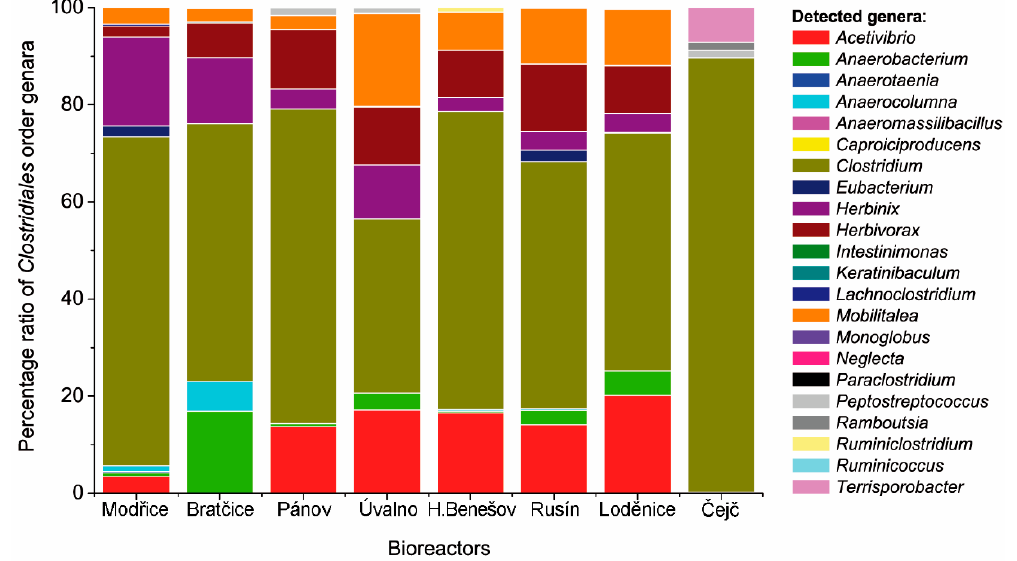
Figure 2. Visualization of the genera composition in each biogas plant and mean of its abundance to total microbial count.